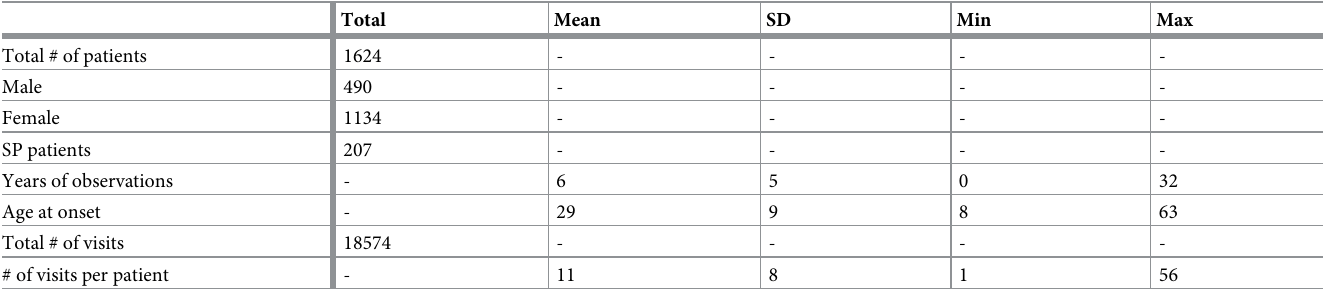
Table 1. Statistics on the raw